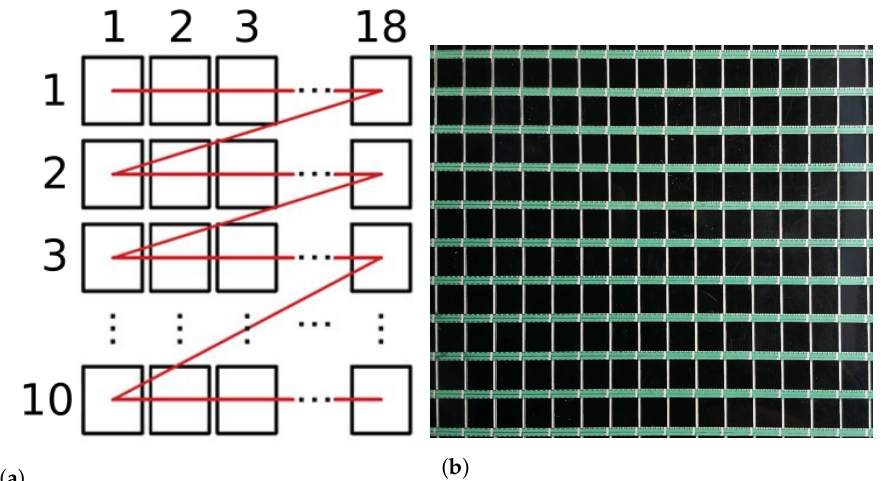
Figure 6. Illustrative presentation of robot trajectory during Stage I of the calibration procedure. ( a ) Robot trajectory path. ( b ) E-skin surface patch covered by robot